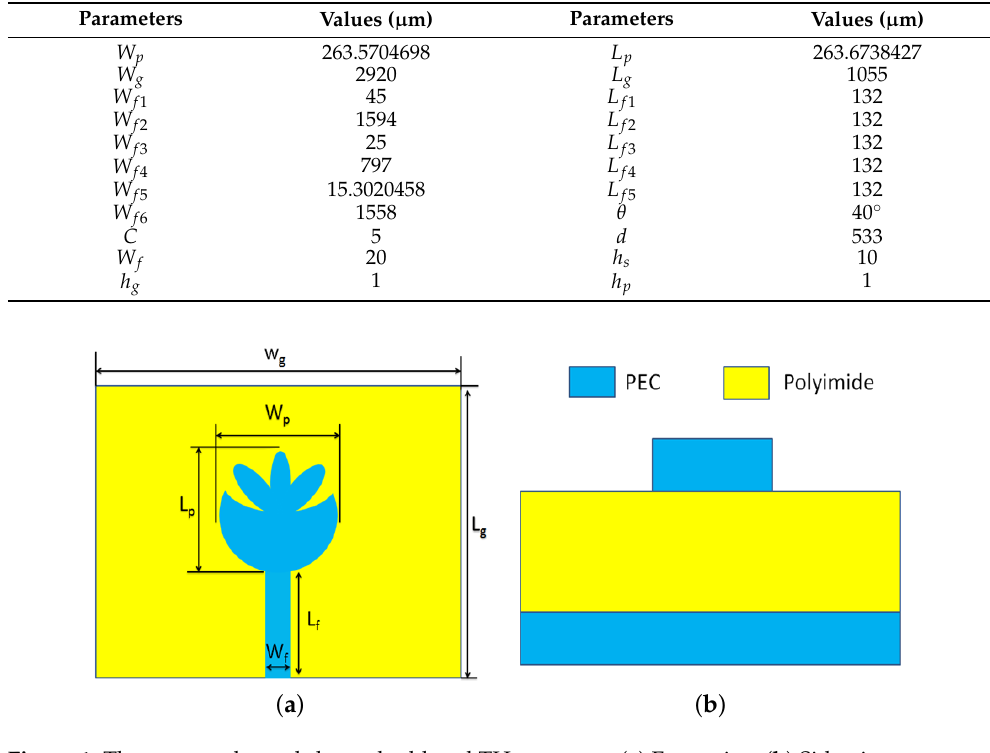
Figure 1. The proposed novel shape dual-band THz antenna: ( a ) Front view ( b ) Side view.